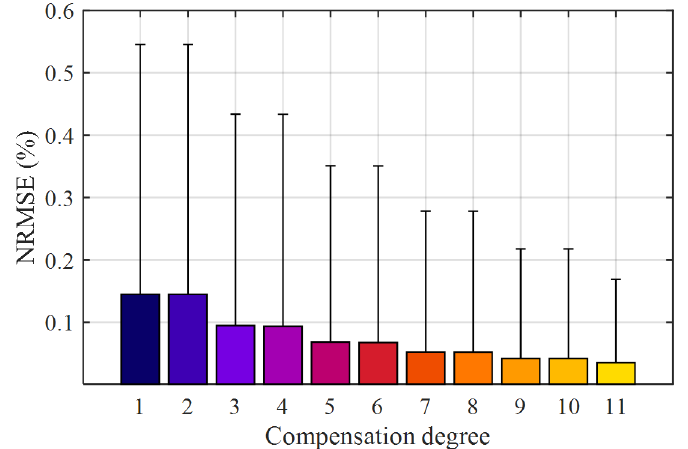
Figure 6. Average (bars) and 95th percentile values (error bars) of the NRMSE obtained with HD compensations of different degrees; transformer CT1, class E 1 of primary current waveforms.